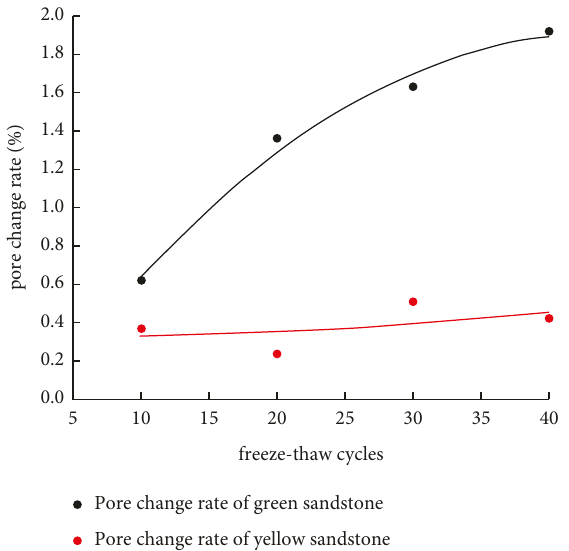
Figure 8: Fitting curve of porosity change rate and freeze-thaw